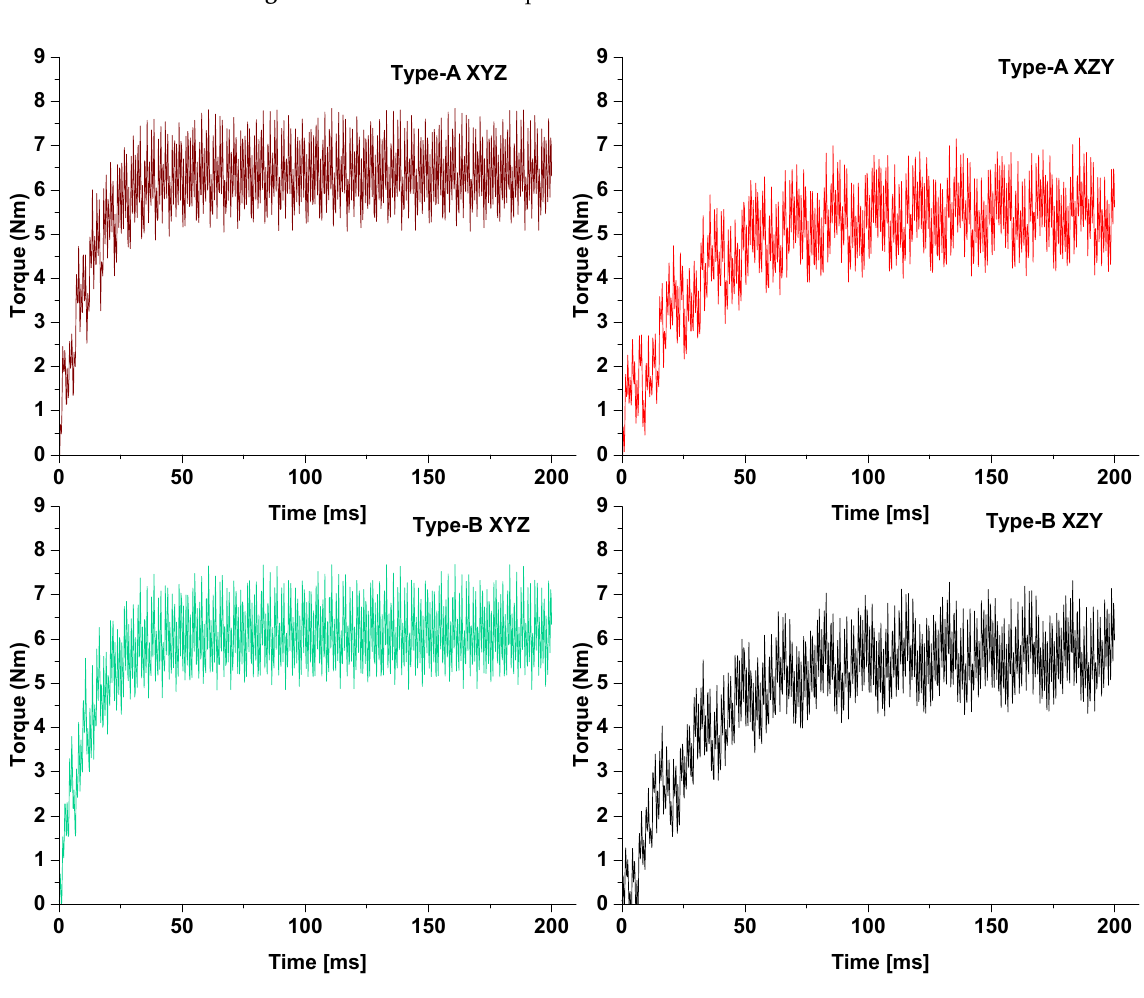
Figure 6. Field currents comparison.